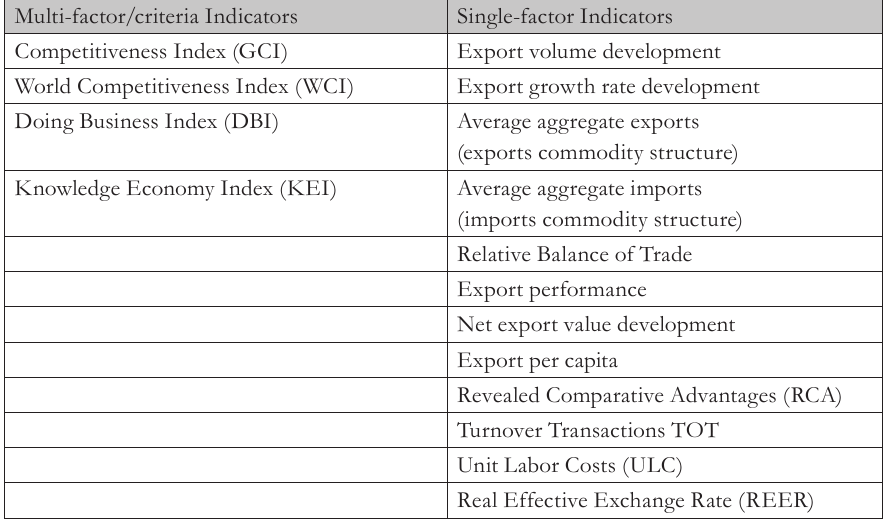
Tab. 1 – Indicators of competitiveness. Source: Baláž et al.